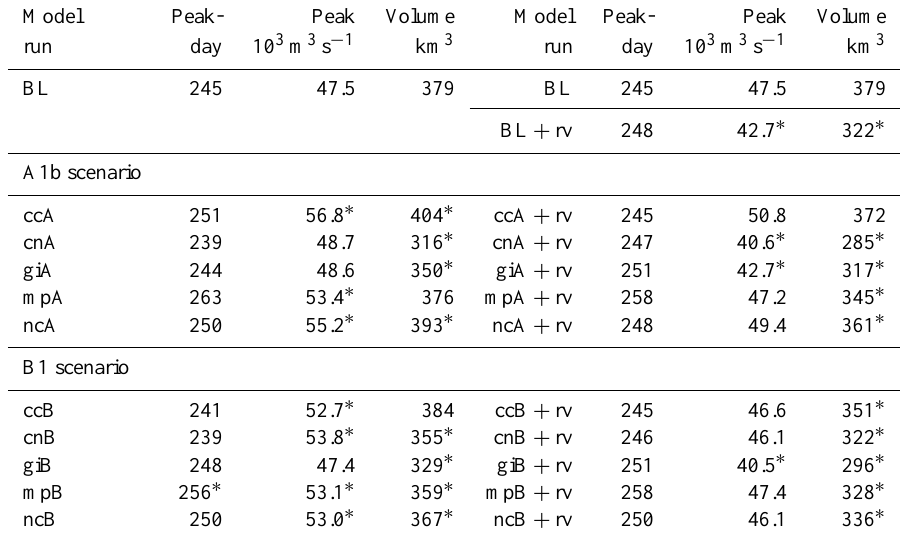
Table 6. Flood parameters in Kratie for model runs computed as an average of 10yr discharge data (2032–2041). Statistically significant ( p < 0 . 05) changes compared to baseline (1982–1992) are marked with star ( ∗ ). The flood volume is computed as the cumulative flow from the start of June to the end of